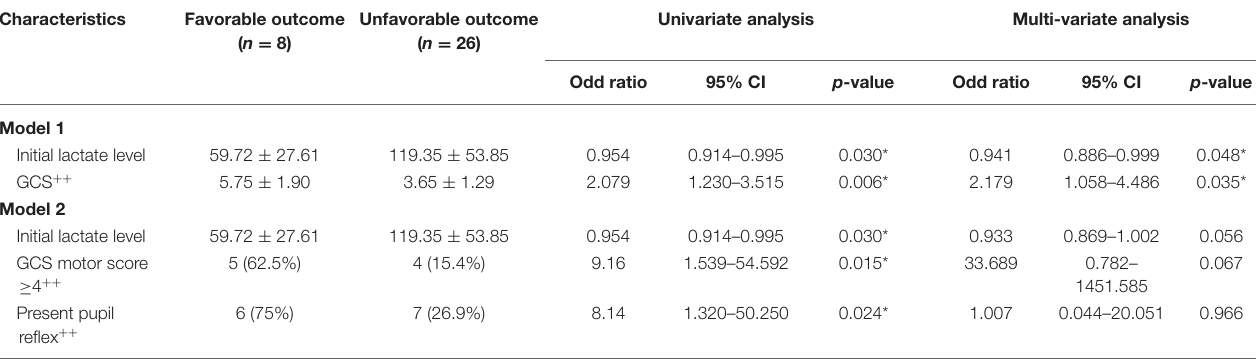
TABLE 3 | Clinical Predictors for 6-month favorable neurological outcomes in children with asphyxial out-of-hospital cardiac arrest who received therapeutic hypothermia.